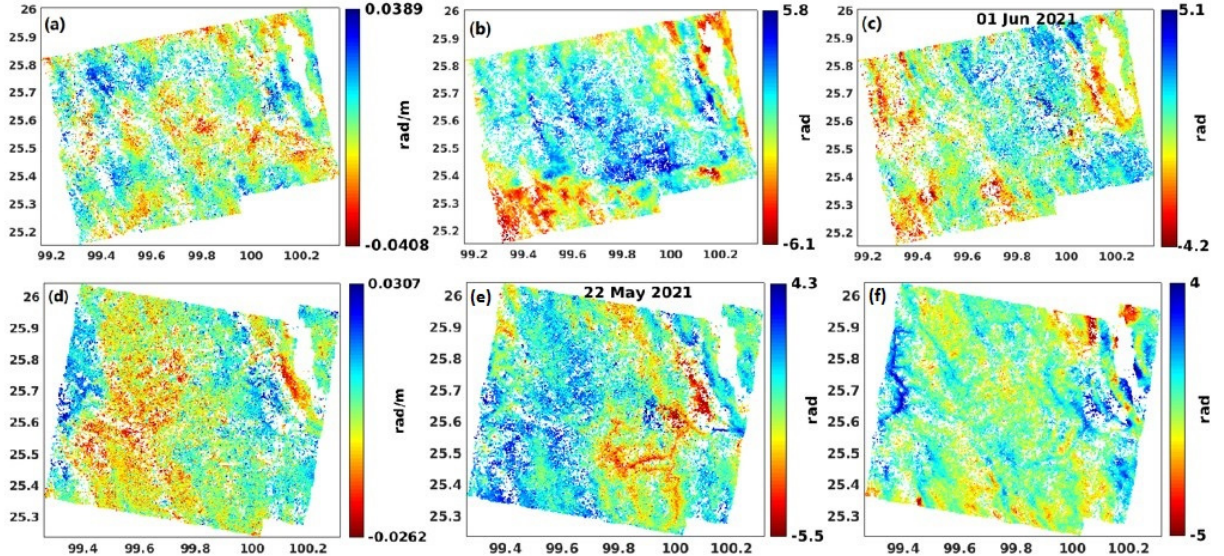
Figure 5. Error diagrams: ( a – c ) represent the SCLA error, master AOE, and slave AOE estimated from the ascending data, respectively; and ( d – f ) represent the SCLA error, master AOE, and slave AOE estimated from the descending data, respectively.